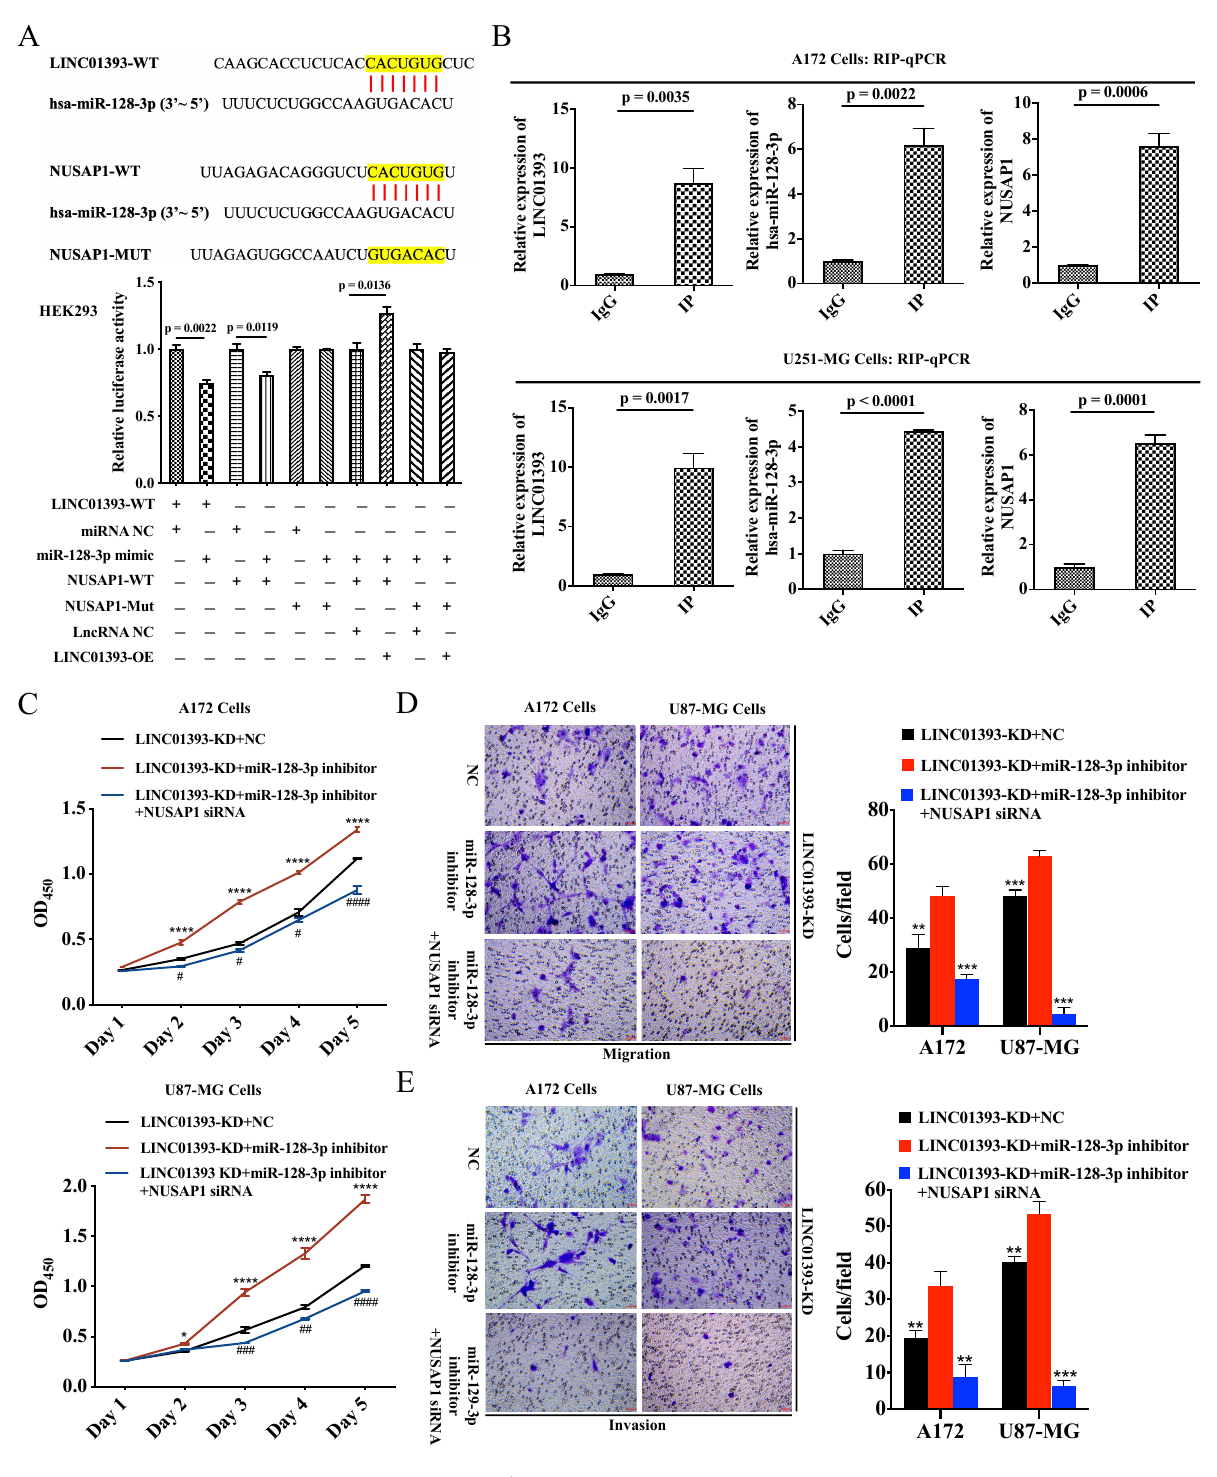
Figure 5. LINC01393 functions as a ceRNA against miR-128-3p to promote NUSAP1 expression in vitro. ( A ) Results of the dual-luciferase reporter gene assay in HEK-293 cells. ( B ) RIP-qPCR assay for LINC01393, miR-128-3p and NUSAP1 expression using anti-Ago2, compared to anti-IgG in cells. ( C ) CCK-8 assays to assess the proliferation rate of LINC01393-KD cells (A172, U87-MG) after transfected with the indicated empty, miR-128-3p inhibitor, miR-128-3p inhibitor+NUSAP1-siRNA. ( D , E ) Transwell migration. ( D ) and Matrigel invasion assays. ( E ) of LINC01393-KD cells (A172, U87- MG) after transfected with the indicated empty, miR-128-3p inhibitor, miR-128-3p inhibitor+NUSAP1- siRNA. Representative staining images are presented (Scale bar = 50 µ m). All data are represented as mean ± SEM of 3 independent experiments. * p < 0.05; ** p < 0.01; *** p < 0.001; **** p < 0.0001, # p < 0.05, ## p < 0.01, ### p < 0.001, #### p < 0.0001, relative to